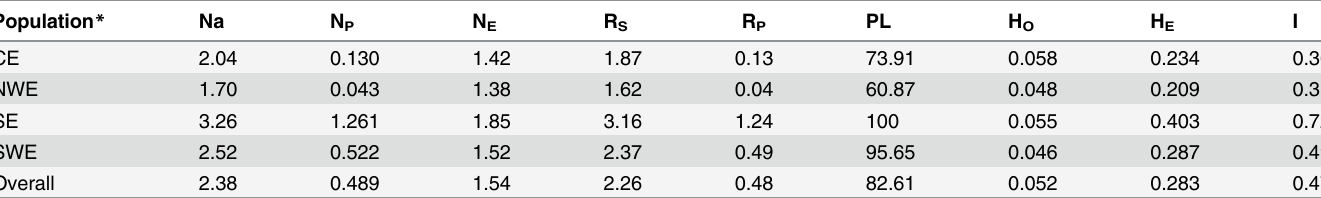
Table 4. Summary of the population diversity indices averaged over 23 loci. Population